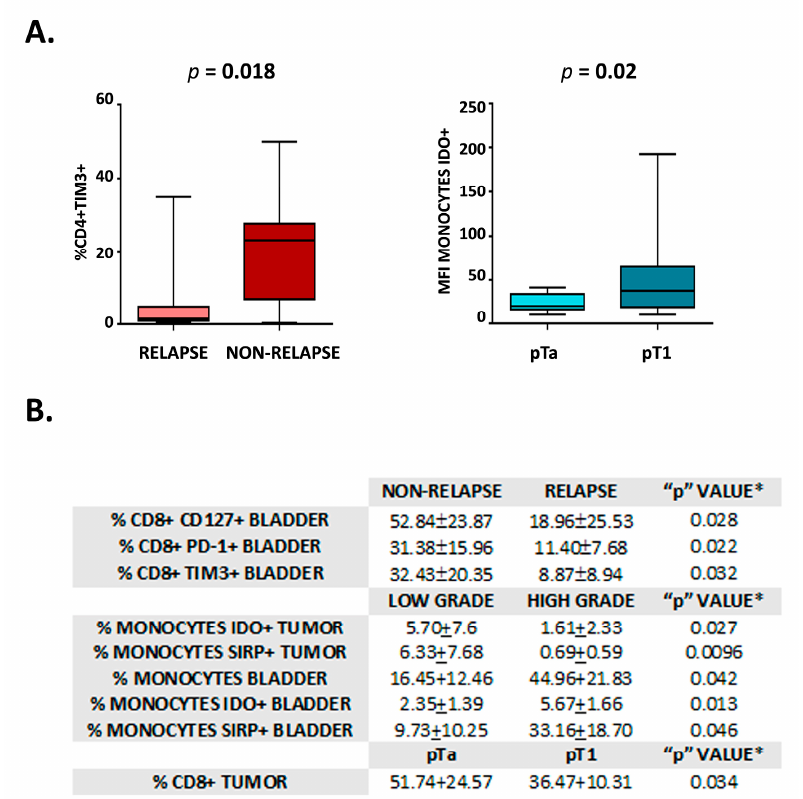
Figure 3. Analysis of immune markers for tumor evolution and patient outcome. ( A ) Graphics show the percentage of CD4+ TIM3+ lymphocytes in the peripheral blood of individuals with Non-relapse vs. Relapse ( left ) and the percentage of monocytes IDO+ in the peripheral blood of individuals with pTa vs. pT1 ( right ). Statistical significance is shown ( p ). ( B ) Table showing the statistically significant results of the univariable analysis to compare individuals with either Non-relapse/Relapse, Low grade/High-grade tumors, and pTa/pT1 tumors. Values correspond to mean ± SD, * student t -test. 3.3. CD4+ CD27+ Cells and IDO+ Monocytes Are Independent Markers for Tumor Progression In order to determine whether previously analyzed immune markers could be used as independent markers for tumor progression or patient outcome, a multivariable logistic regression analysis was performed considering relevant variables such as histological grade and tumor size. This analysis showed that the percentage of CD4+ CD27+ cells and IDO+ monocytes remained independent predictors of tumor progression (Figure 4A). This model, which combines immune parameters of patient peripheral blood with histological grade and tumor size, discriminates pTa and pT1 tumors with a sensitivity of 75%, a specificity of 96.65%, a positive predictive value of 90%, and a negative predictive value of 88% (area under ROC curve is 0.9783) (Figure